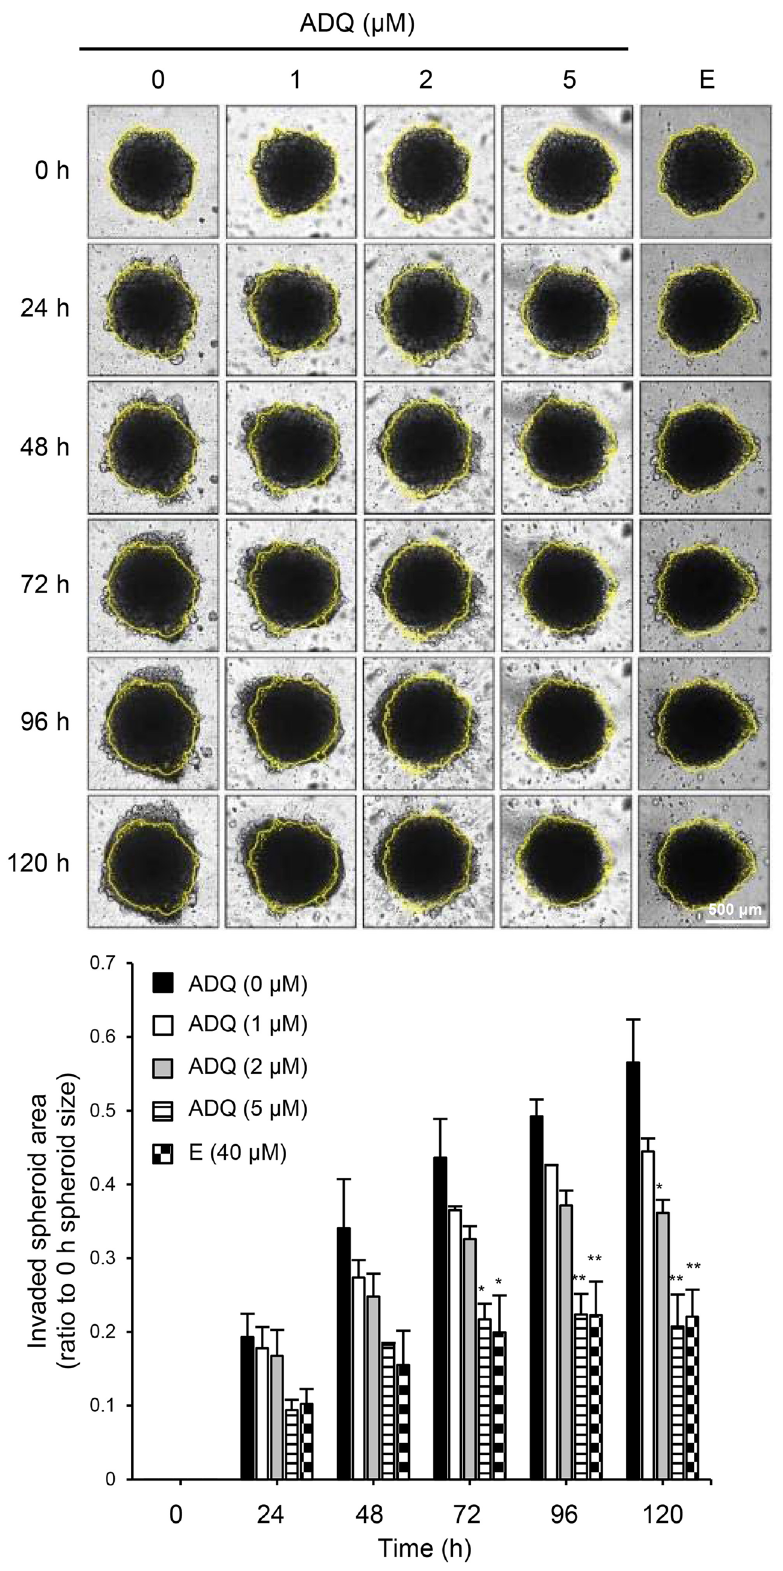
Figure 2. MTS invasion in Matrigel was inhibited by treatment with ADQ. SK-Hep1 spheroids were incubated with ADQ or emodin (E; 40 μM; positive control) for 48 h in 10% FBS media. Microscopic images were captured by a JuLI stage real-time imaging system at each time point. Yellow lines indicate the outline of the MTS at 0 h. The invading area or length of the spheroids was measured using ImageJ. The measured value of each time point was normalized to that of 0 h. The scale bar is 500 μm. Data are representative of three experiments and expressed as the means ± SEM. Data were analyzed by one-way ANOVA followed by Holm-Šídák’s post hoc test; *p < 0.05, **p < 0.01, and ***p < 0.001 relative to the ADQ-untreated